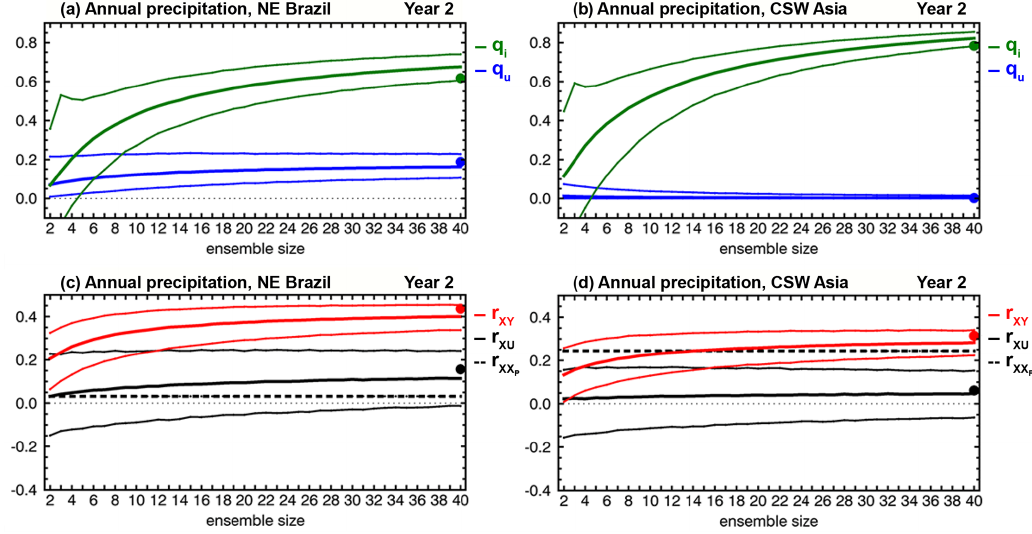
/σ 2 /σ 2 , Eq. (A14), in blue, and q i = σ 2 , Eq. (A15), in Y u Y Y i Y p